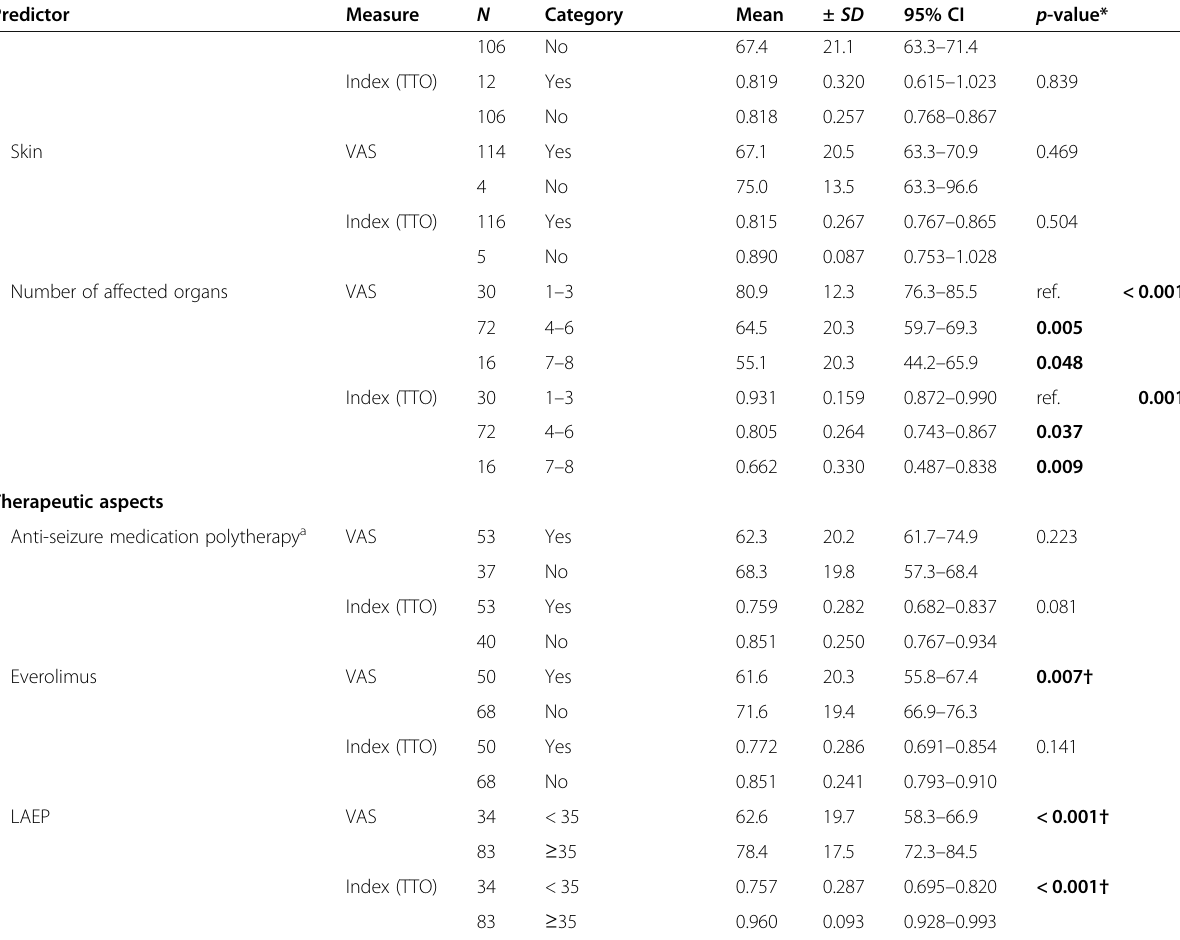
Table 2 Comparisons of generic quality of life among individuals with TSC, as measured by the EQ-5D (German version) questionnaire, according to several potential predictors and assessed by the Kruskal – Wallis and Chi-square tests (Continued)